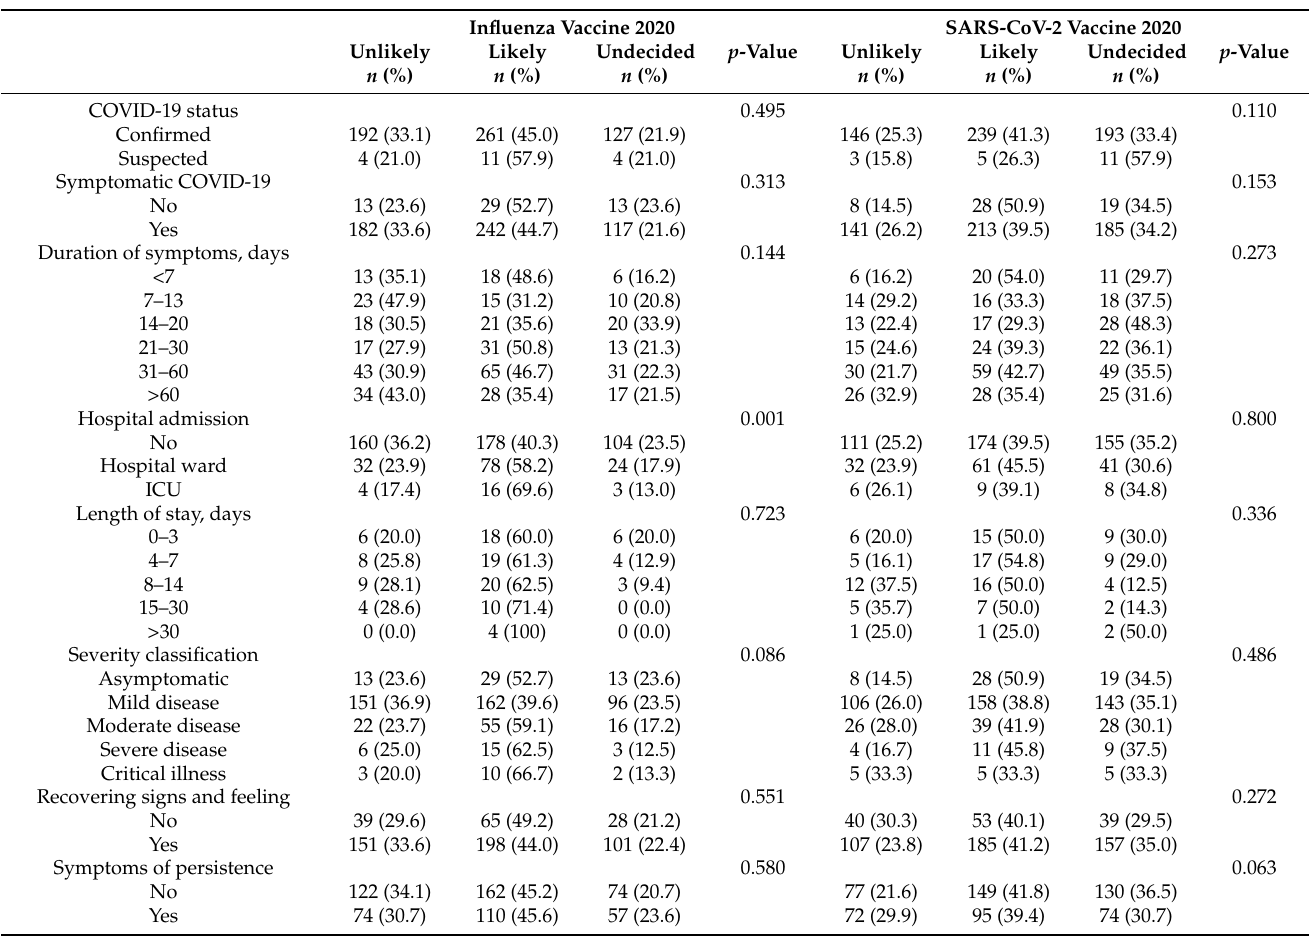
Table 3. Clinical characteristics of